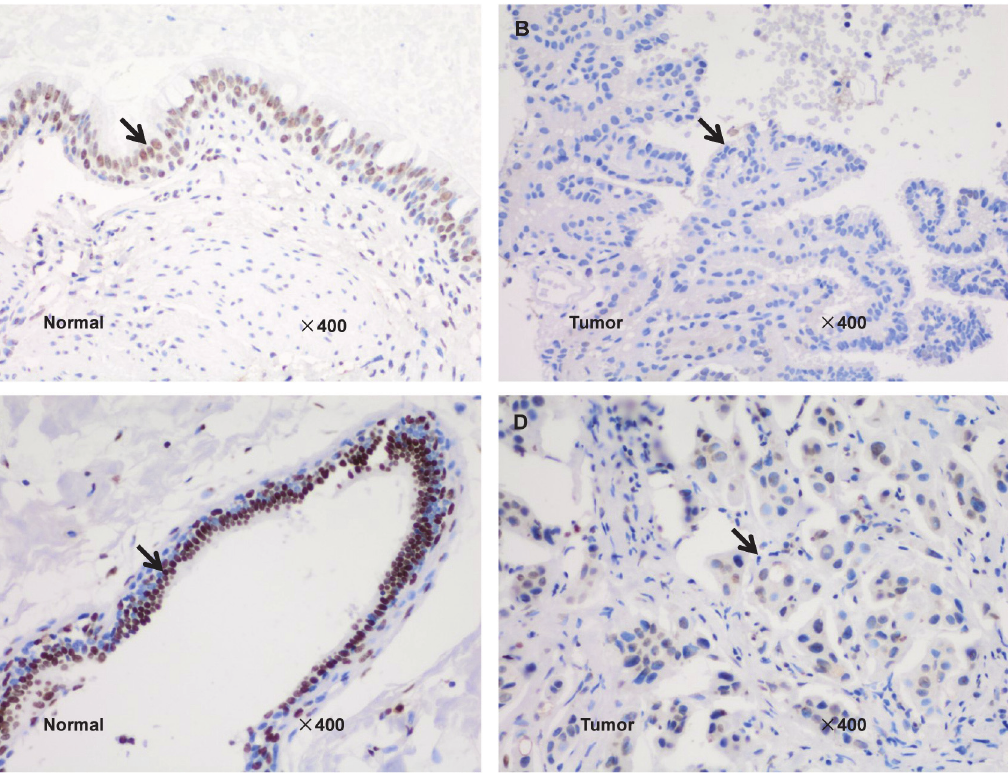
Fig 4. Expression of Msh3 protein in normal and tumor tissues of MSH3 mutation carriers. Arrows indicate the location of the expression of Msh3 protein. A, the normal ovarian tissue of the proband from family No. 49. B, the ovarian tumor tissue of the proband from family No. 49. The loss of Msh3 expression was observed in the tumor tissue. C, the normal breast tissue of the sister of the proband from family No. 75. D, the breast tumor tissue of the sister of the proband from family No. 75. Msh3 is expressed strongly in the normal tissue and weakly in the tumor tissue.